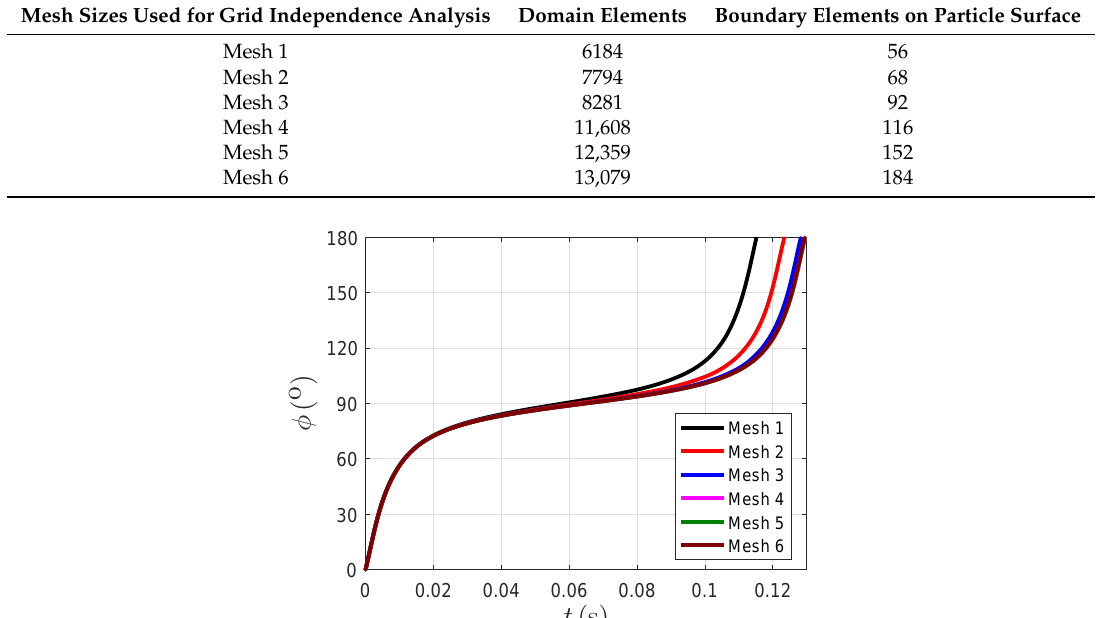
Table 1. Six meshes for grid independence analysis.